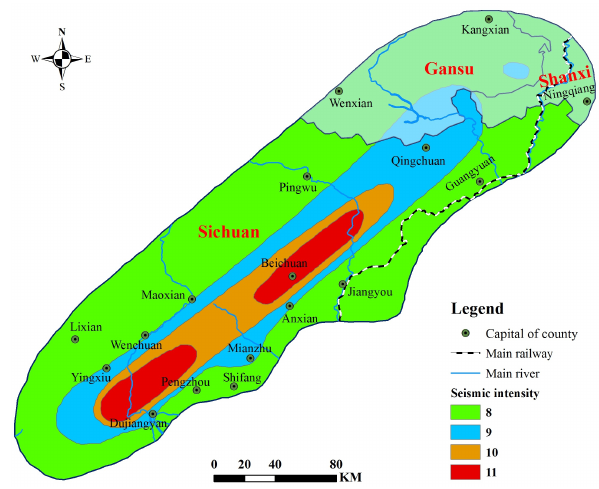
Figure 1. Map of the 2008 Wenchuan earthquake-affected